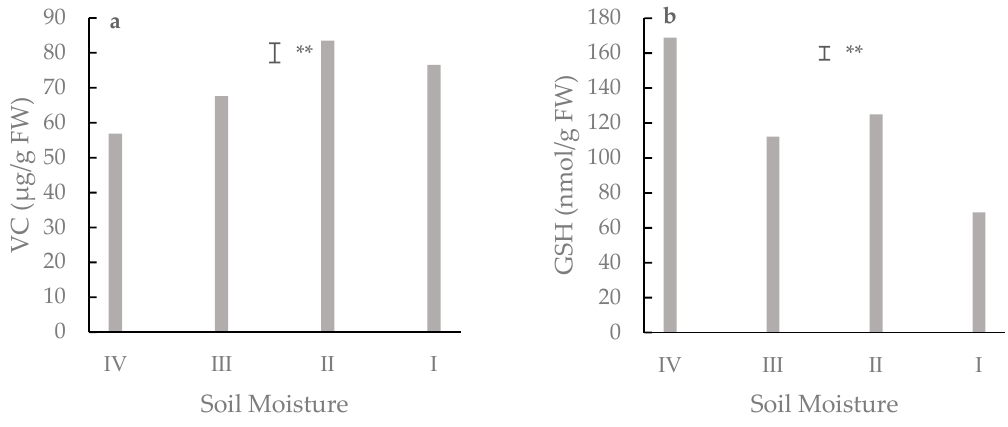
Figure 9. The content of ( a ) Ascorbic acid (ASA) and ( b ) reduced glutathione (GSH) in alfalfa root under various soil moisture treatments (See Figure 2 for soil moisture abbreviations). ** p < 0.01.